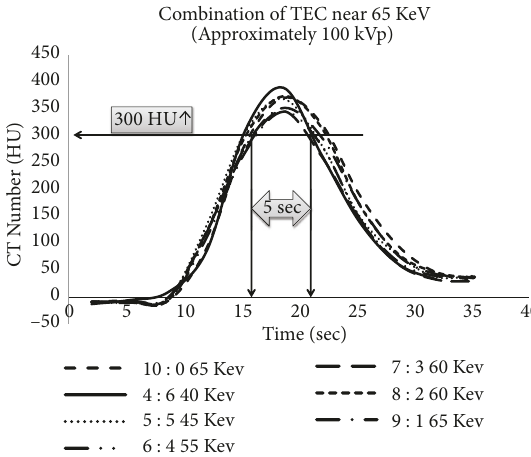
Figure 10: Determination of the best combination of dilution rate and monoenergetic energy using VMI. The combinations that maintained enhancementabove 300 HU were 10:0 at 65 kV, 4:6 at 40 keV, 5:5 at 45 keV, 6:4 at 55 keV, 7:3 at 60 keV, 8:2 at 60 keV, and 9:1 at 65 keV. In addition, the dilution ratio of 6:4 at 55 keV only provided anenhancementlevelof 300HUfor 5 s, whichcorroboratestheTEC using single-energy scanning at 100 kV.